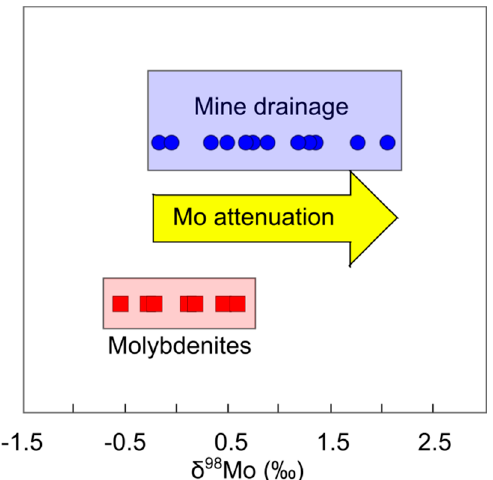
Figure 1. Molybdenum isotopic compositions of mine waste rock drainage and waste rock at the Antamina mine, Peru. δ 98 Mo data are reported relative to NIST-SRM-3134 = +0.25‰. Reprinted (adapted) from Skierszkan et al. [8], with permission from Elsevier.